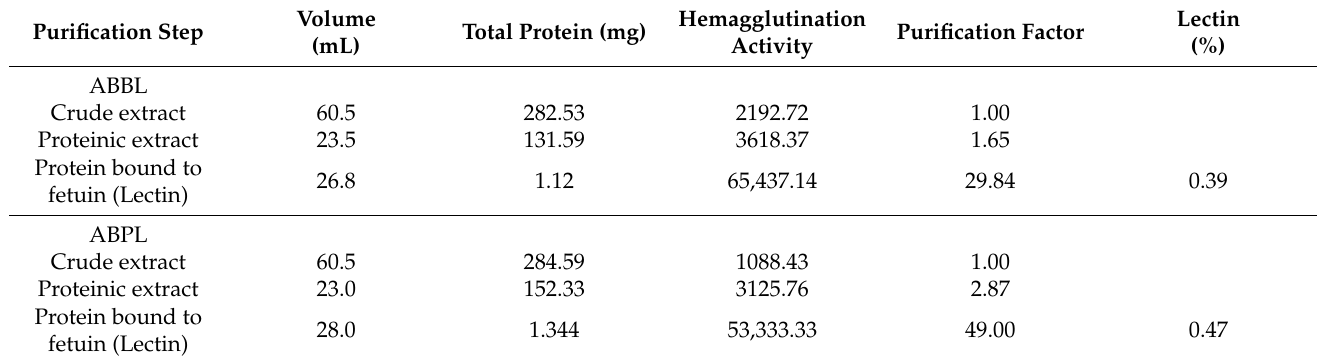
Figure 1. Affinity chromatography with fetuin–agarose matrix of two varieties of Phaseolus coccineus. The lectin was eluted with glycine solution. Table 1. Purification table of the lectin from two varieties of Phaseolus coccineus. Hemagglutination activity/mg of